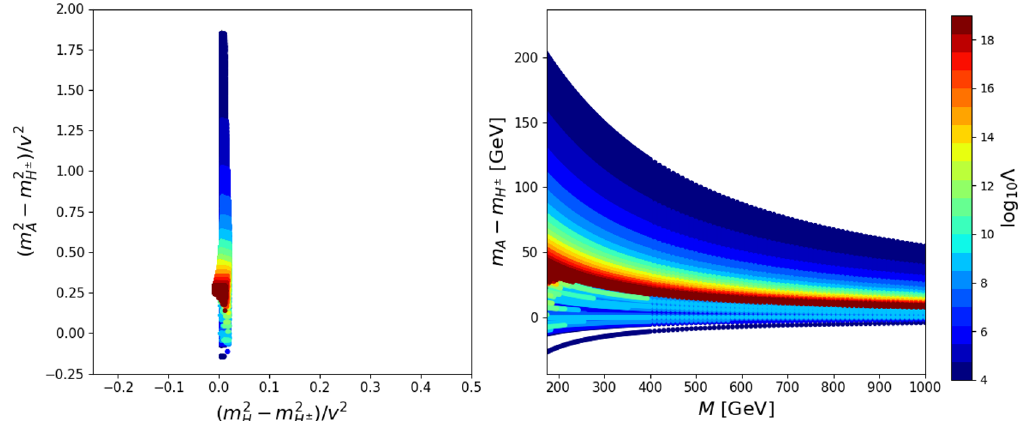
Figure 3 . Possible mass differences among the additional Higgs bosons for tan β = 5 in Type-I. The left figure shows M -independent mass-squared differences. The right figure shows the mass difference between A and H ± as a function of M . The points in different colors correspond to the different value of Λ